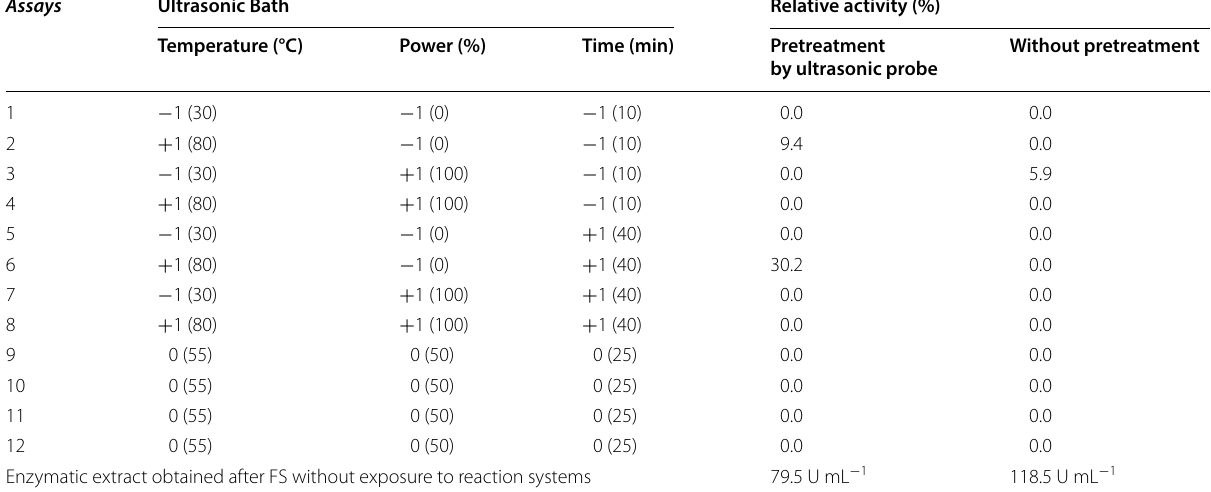
Table 4 Experimental planning matrix (real and coded values) and relative activity results (%) for the conditions evaluated in the reaction system ultrasonic bath with enzymatic extracts produced from swine hair pretreated and non- pretreated with an ultrasonic probe